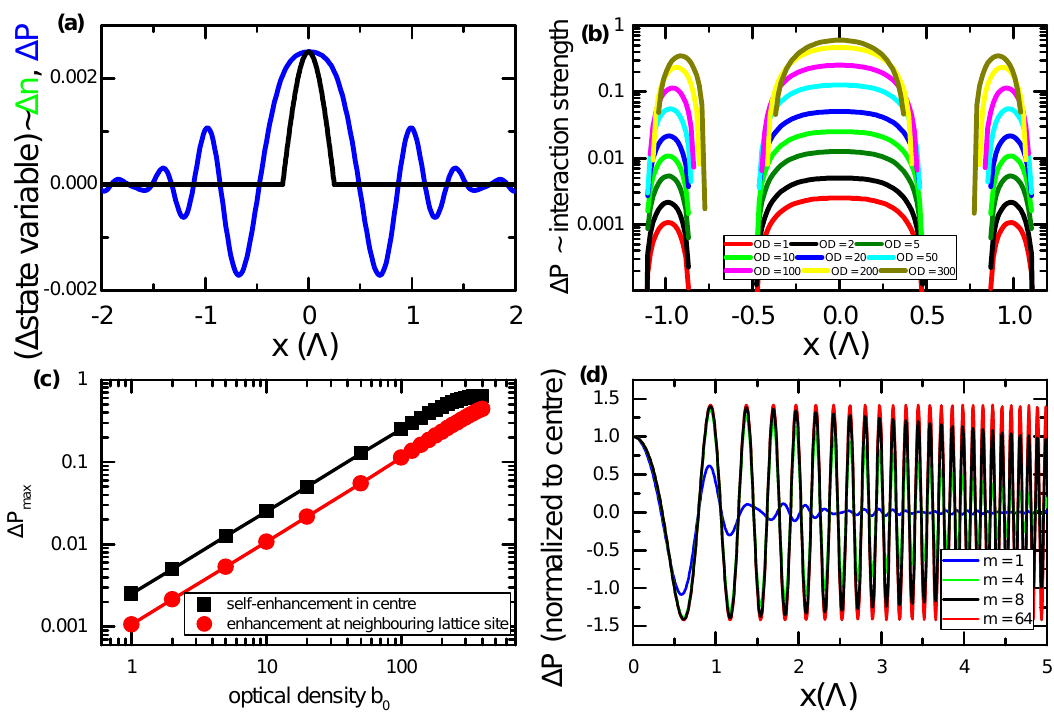
Figure 15. ( a ) 1D cut through 2D profiles of localized perturbation of atomic state (black, scaled to match the feedback pump rate in peak for presentation purposes) and resulting perturbation (i.e., without the homogeneous background) in the pump rate of backward beam (blue) after one round trip in feedback loop. The central lobe leads to the self-enhancement of the instability, the first side lobes to an enhancement at neighbouring lattice sites. Transverse space is measured in periods of the periodic lattice. The calculations are done in 2D and only profiles are presented. ( b ) Feedback pump rate for different optical densities in line centre b 0 in logarithmic scale. ( c ) Peak values of central (black squares) and first lopes (red circles) for different optical densities in line centre b 0 in logarithmic scale. For all panels the atomic perturbation has been small (0.1), homogeneous input pump rate P = 1, detuning 7 Γ , R = 1. b 0 = 1 in ( a ). ( d ) 1D calculations of perturbation of backward pump rate being a factor of m narrower than in ( a ). Results are then normalized by dividing by pump rate in centre x =